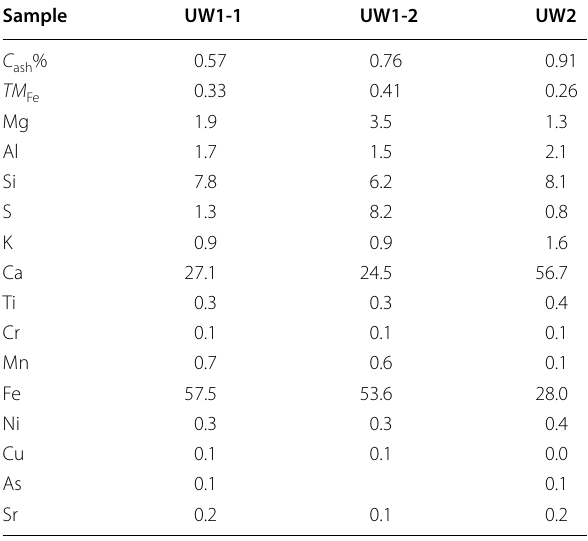
Blank space implies “not detected” C ash is ash content of umoregi wood TM Fe is a tentative true mass percentage of Fe